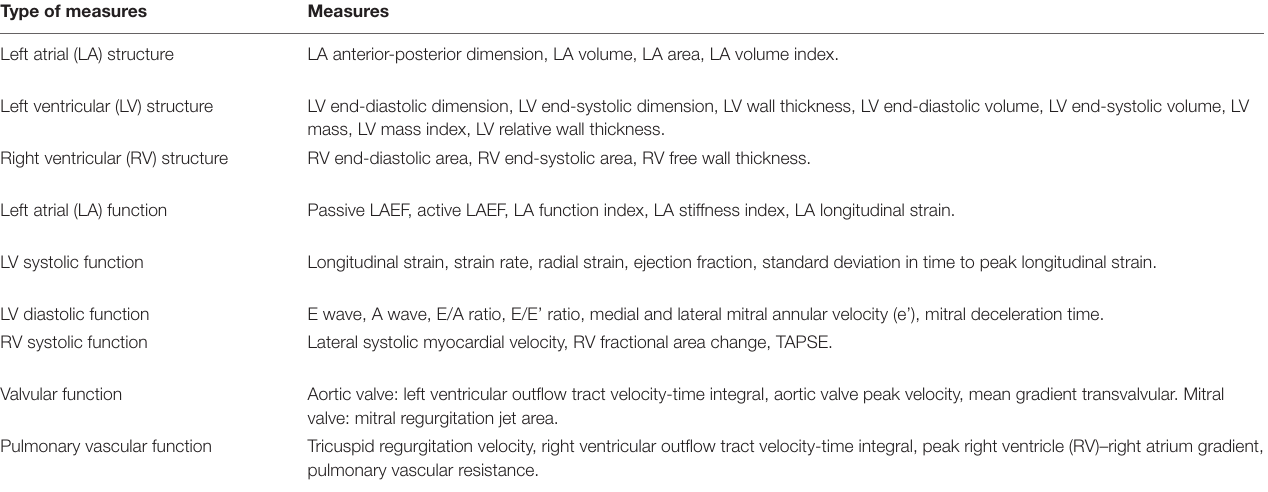
TABLE 2 | Transthoracic echocardiography measures.